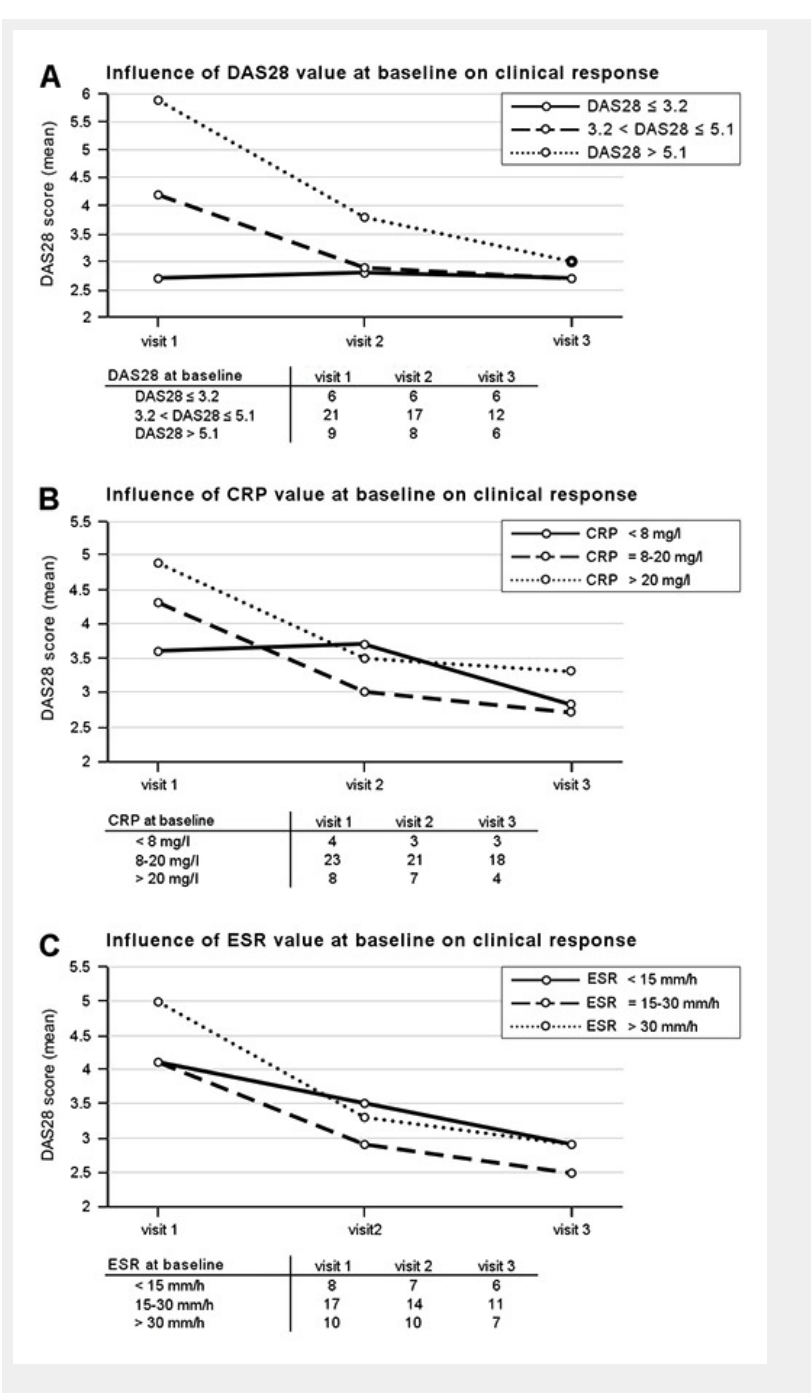
Figure 6 Clinical response over time depending on A) disease activity, B) CRP, and C) ESR values at baseline. The numbers of patients with available assessments at baseline and subsequent visits are listed in the tables. CRP, C-reactive protein; ESR, erythrocyte sedimentation